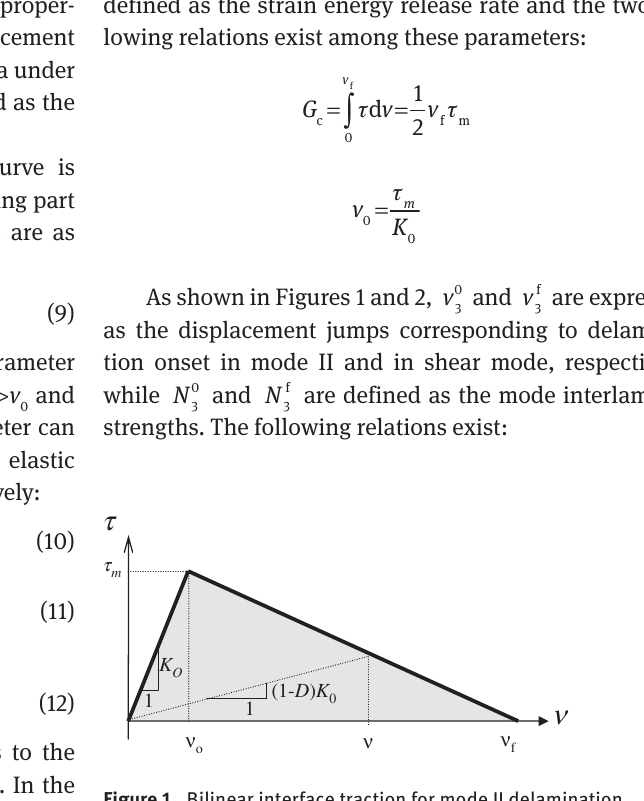
Figure 1 Bilinear interface traction for mode II delamination.